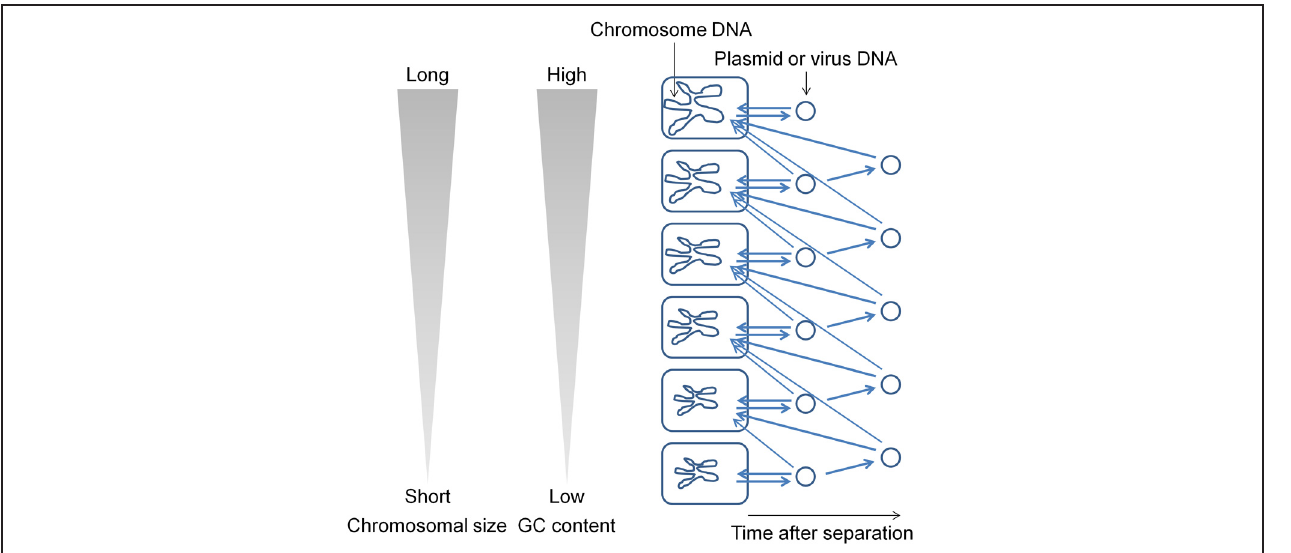
FIGURE 1 | Flow of DNA fragments in